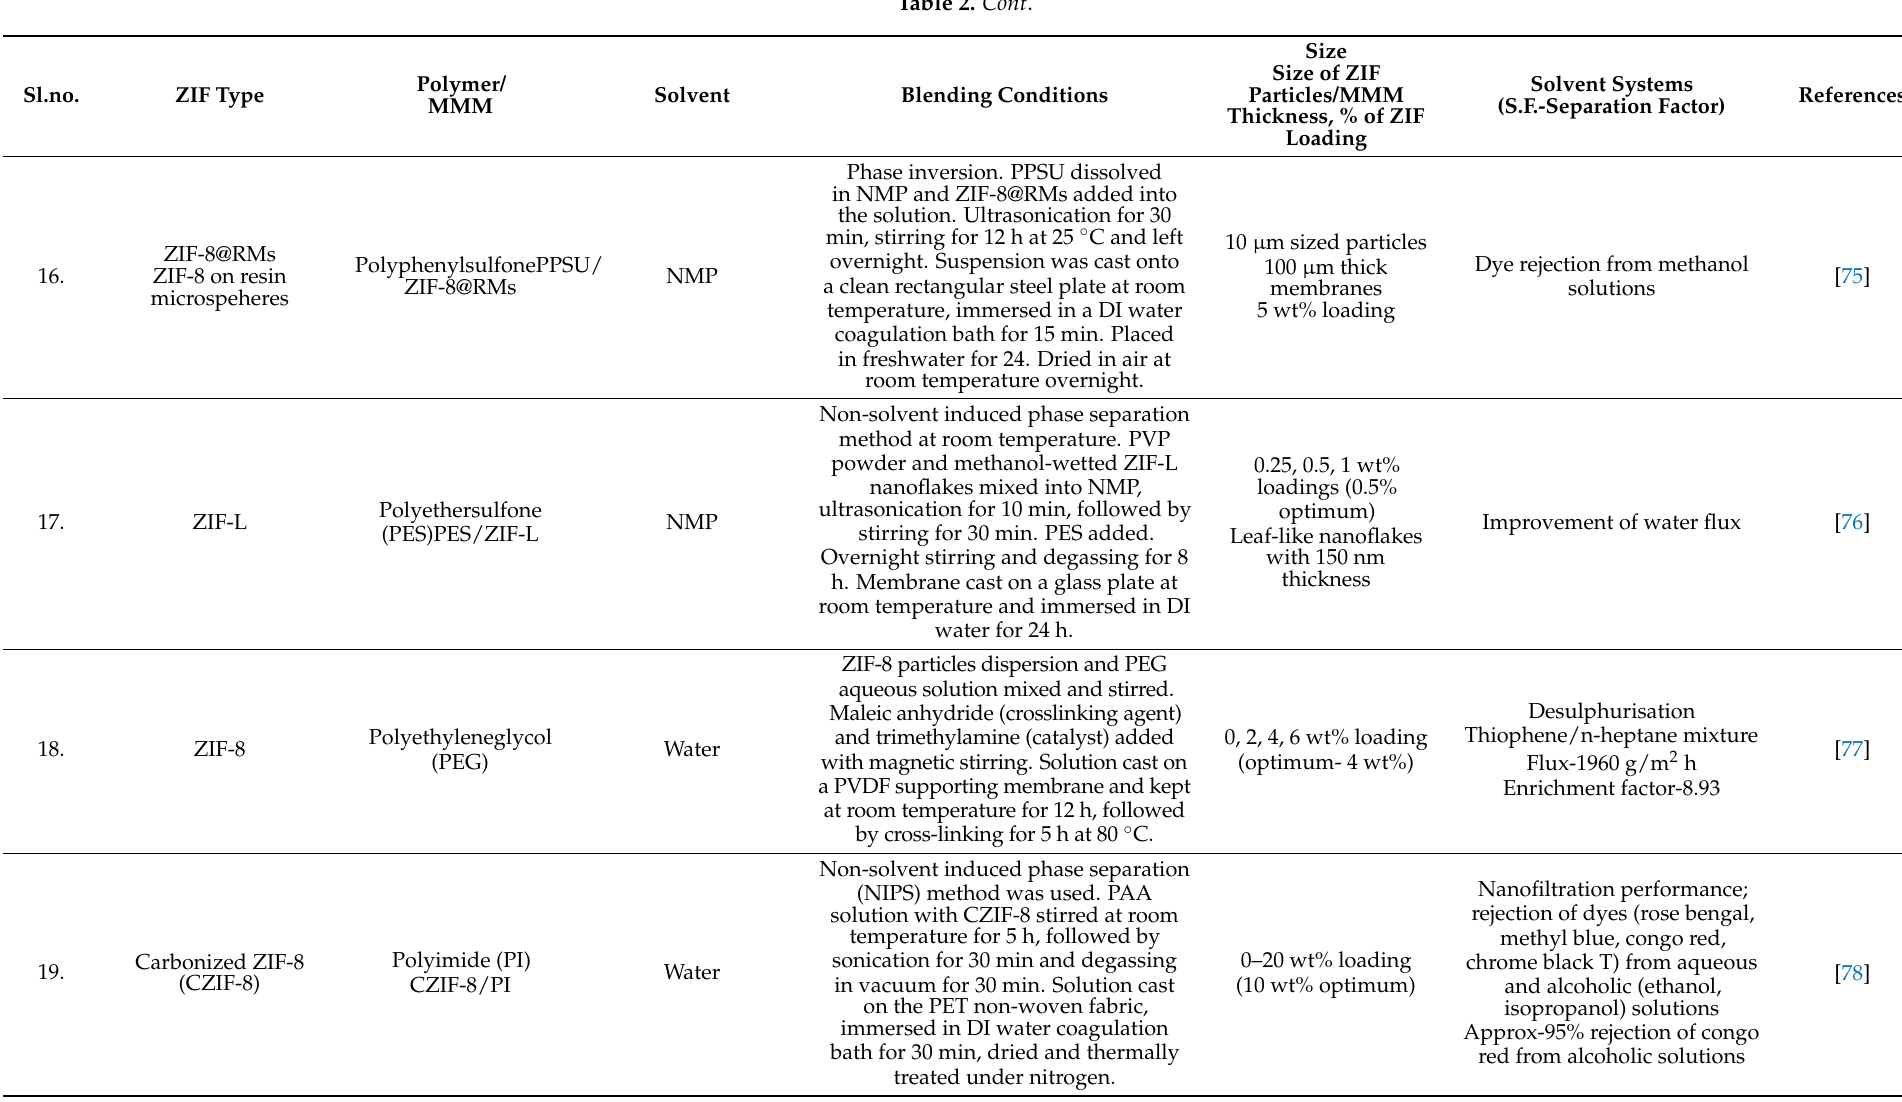
Phase inversion. PPSU dissolved in NMP and ZIF-8@RMs added into the solution. Ultrasonication for 30 min, stirring for 12 h at 25 ◦ C and left overnight. Suspension was cast onto PolyphenylsulfonePPSU/ NMP a clean rectangular steel plate at room ZIF-8@RMs temperature, immersed in a DI water coagulation bath for 15 min. Placed in freshwater for 24. Dried in air at room temperature overnight. Non-solvent induced phase separation method at room temperature. PVP powder and methanol-wetted ZIF-L nanoflakes mixed into NMP, ultrasonication for 10 min, followed by NMP stirring for 30 min. PES added. Overnight stirring and degassing for 8 h. Membrane cast on a glass plate at room temperature and immersed in DI water for 24 h. ZIF-8 particles dispersion and PEG aqueous solution mixed and stirred. Maleic anhydride (crosslinking agent) and trimethylamine (catalyst) added Water with magnetic stirring. Solution cast on a PVDF supporting membrane and kept at room temperature for 12 h, followed by cross-linking for 5 h at 80 ◦ C. Non-solvent induced phase separation (NIPS) method was used. PAA solution with CZIF-8 stirred at room temperature for 5 h, followed by sonication for 30 min and degassing Water in vacuum for 30 min. Solution cast on the PET non-woven fabric, immersed in DI water coagulation bath for 30 min, dried and thermally treated under